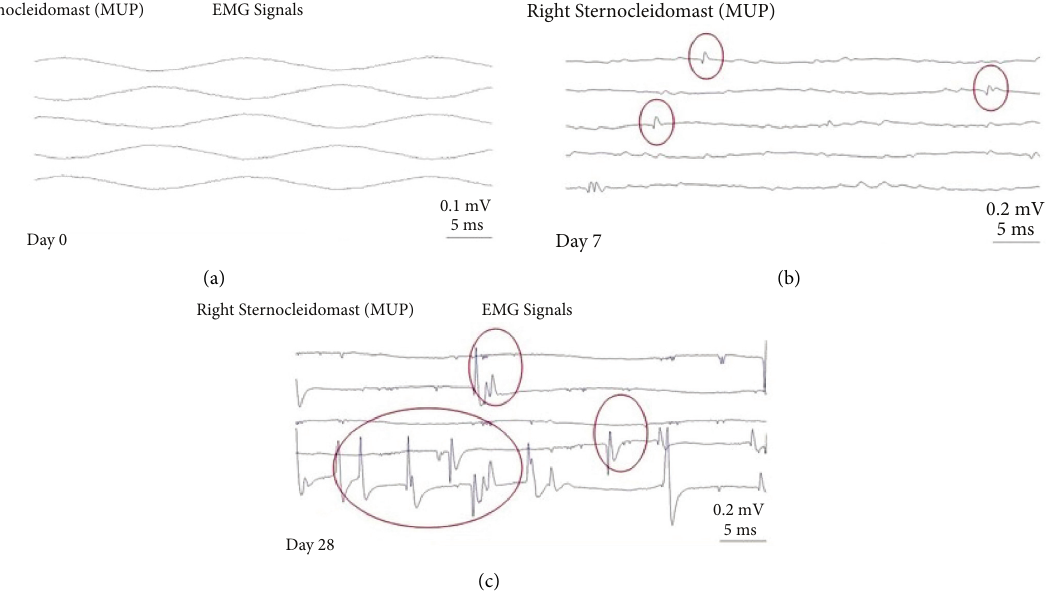
Figure 5: Electromyograms on days 0 (a), 7 (b), and 28 (c) after 6IU botulinum toxin administration. Findings of SEA are circled in red. Right Sternocleidomast (MUP)